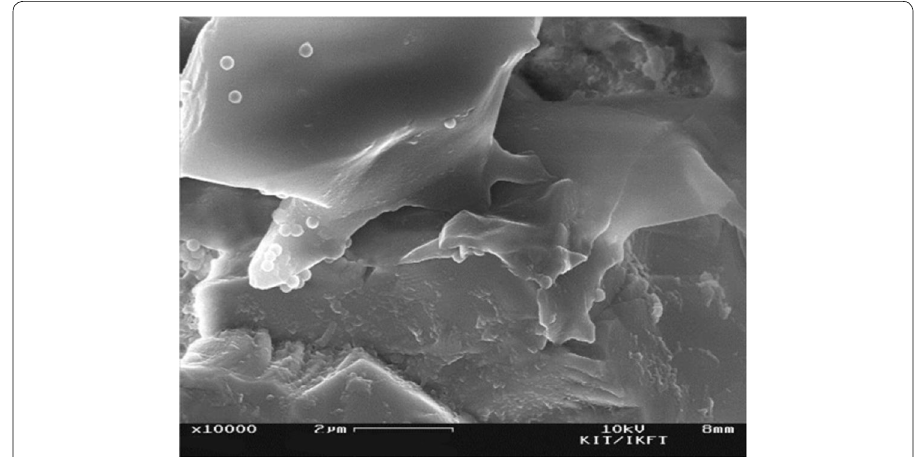
Fig. 18 SEM (SE image) of barite covered with spherical phases, sample 10.1 (20 °C/200 bar)